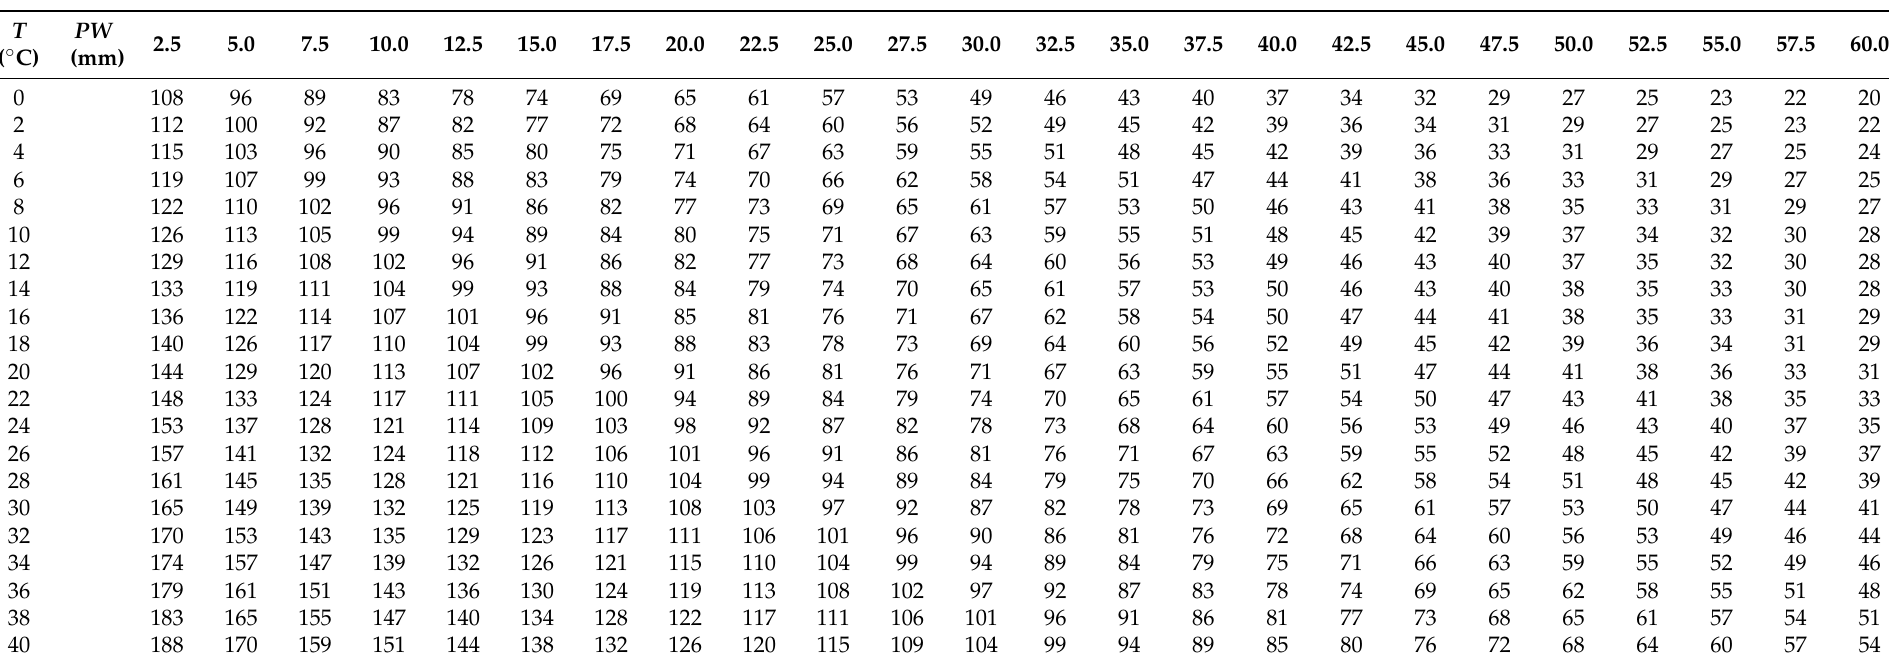
Table 1. A lookup table of the net cooling power of an “ideal black” radiative cooler. (Unit: W/m 2 ; T cooler = T amb ; solar absorption excluded; atmosphere model: mid-latitude